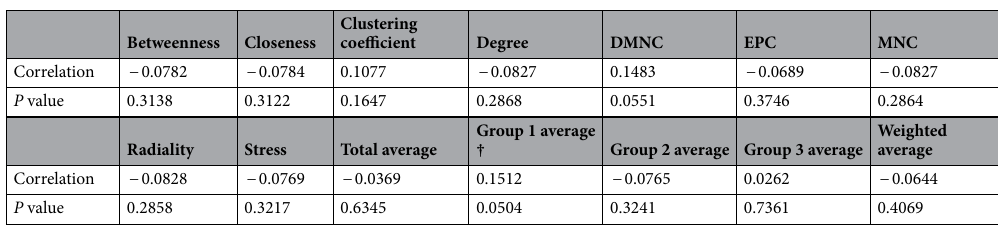
Table 3. Correlation analysis of mutation rates and centrality indices shows that there is no statistically significant correlation between any of the centrality indices and normalized mutation rates. Mutation data are from a study by Kunstman et al. 37 . † Group and weighted averages have been defined as following: Group 1 average: average of ranks of DMNC and CC. Group 2 average: average of ranks of closeness, radiality, betweenness, stress and EPC. Group 3 average: average of ‘Group 1 average’, ‘Group 2 average’ and ranks of degree. Weighted average: average of ‘Group 1 average × 0.1’, ‘Group 2 average ✕ 0.7’ and ranks of ‘degree ×